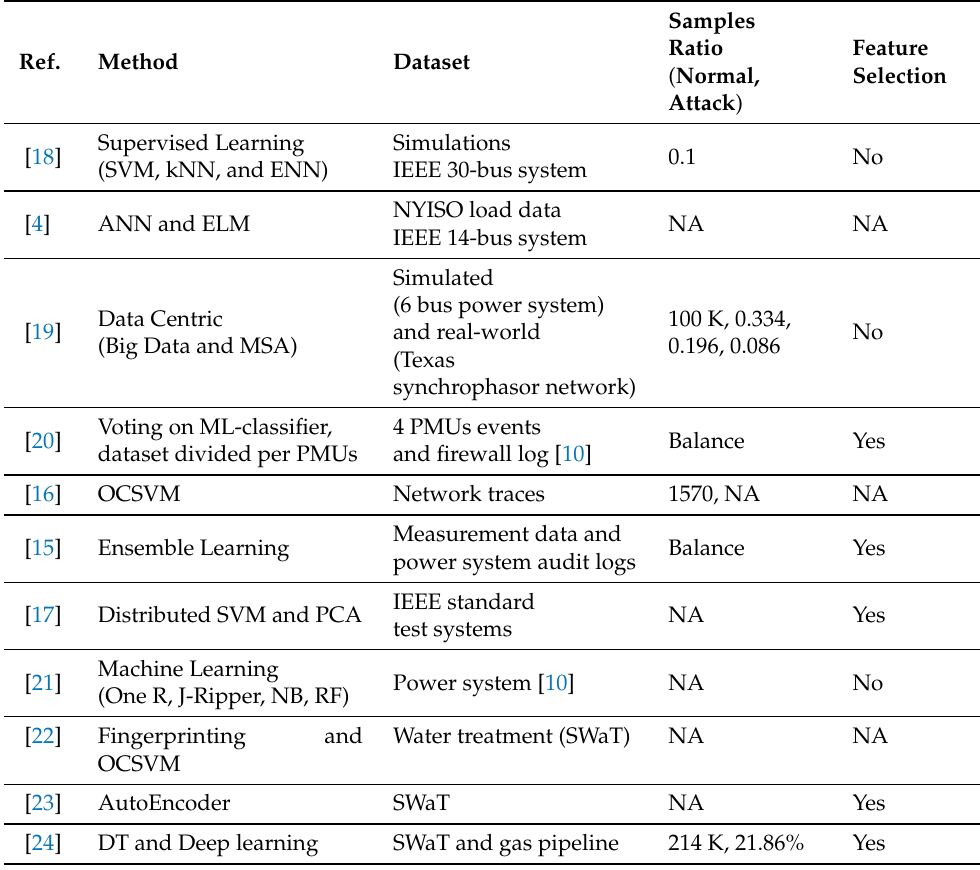
Table 1. Summary of related work on FDIA detection using machine learning